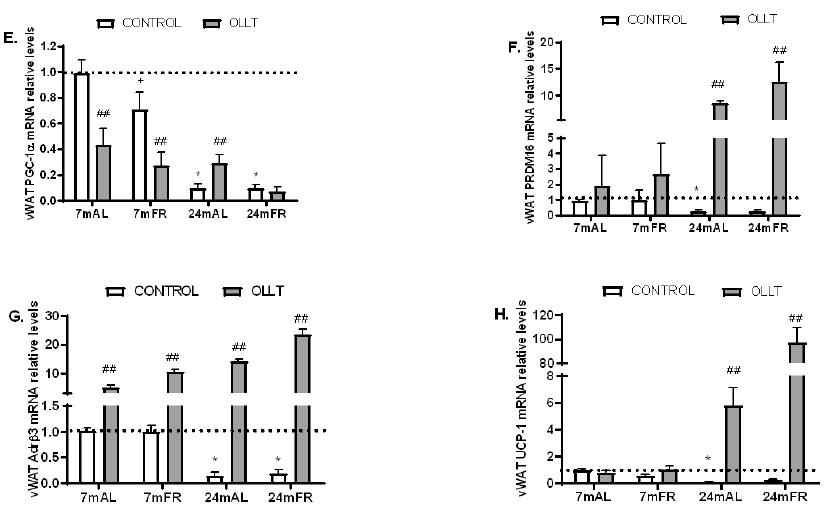
Figure 8. mRNA relative levels of CPT-1b ( A ), MCAD ( B ), LCAD ( C ), TNF- α ( D ), PGC-1 α ( E ), PRDM16 ( F ), Adr β 3 ( G ), and UCP-1 ( H ) in the visceral adipose tissue in the 7- and 24-month-old rats fed ad libitum (AL) or food-restricted (FR), before (CONTROL) and after an oral lipid loading test (OLLT). Results are the mean ± SEM of 8–10 rats per group, conducted in duplicates. Unpaired Student’s t -test, * p < 0.05 compared to the 7-month-old rats under the same feeding protocol; + p < 0.05, ++ p < 0.0001 compared to the age-matched ad-libitum-fed rats; # p < 0.05, ## p < 0.0001 compared to the basal levels before a fat load of the age-matched rats under the same feeding protocol.